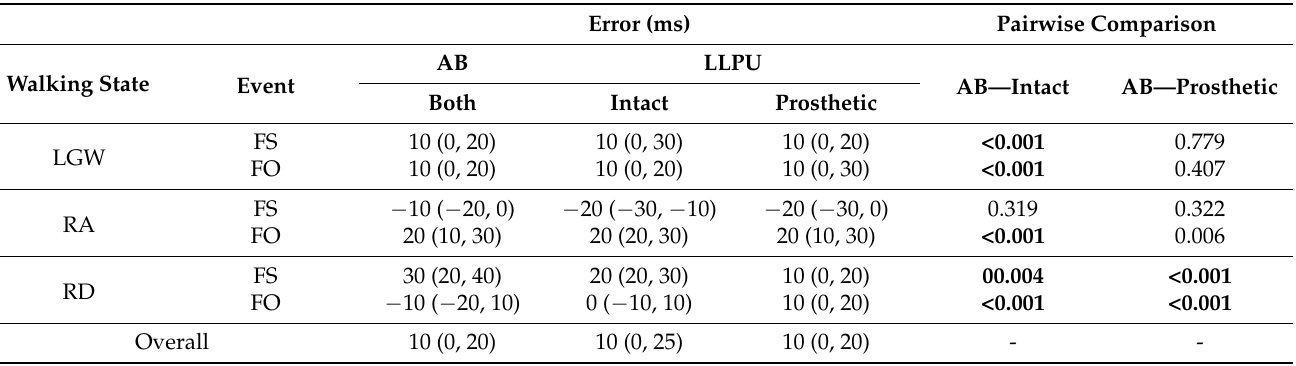
Table 3. Temporal error (median (IQR1, IQR3)) results of GED algorithm between the proposed algorithm and validated Xsens results. Pairwise comparison ( p -values) results between accuracy of AB and LLPU group for each mode and side.